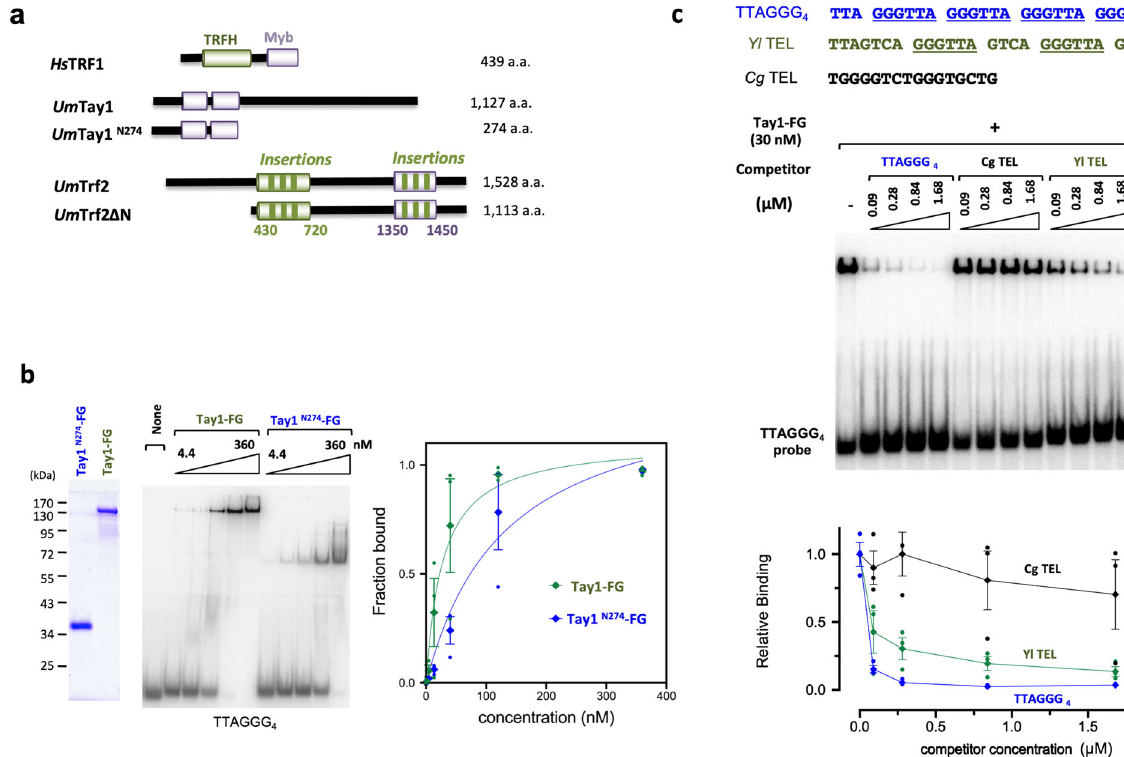
Fig. 1 The DNA-binding activity of Ustilago maydis Tay1. a Schematic illustrations of the domain structures of the U. maydis Tay1 and Trf2 proteins analyzed in this study, as well as that of human TRF1, a prototypical member of the TRF/TBF1 protein family. The TRFH and Myb domains are shown in green and purple, respectively. All the U. maydis recombinant proteins examined in this work also contain a C-terminal FLAG tag (as indicated by the designations Tay1-FG and Tay1 N274 -FG), which is not illustrated. b EMSA analysis of the DNA-binding activities of Tay1-FG and Tay1 N274 -FG (TayF1 and Tay1 N274 carrying a C-terminal FLAG tag). The assays were performed using a series of progressive, 3-fold increases in protein concentrations ranging from 4.4 to 360 nM. A representative set of assays is shown on the left and the quantitation (average ± SEM, n = 3 independent experiments) shown on the right. Previous investigations of Sp Teb1 revealed K d s that range from 20 nM to >1 µ M, possibly owing to the different DNA substrates used in these studies 12,50 . Our estimated K d s for Tay1 and Tay1 N274 (27 and 130 nM, respectively) are broadly in line with these earlier analyses. c The DNA-binding speci fi city of Tay1-FG was examined using three different double-stranded competitor oligonucleotides. The sequences of the competitors are shown on top with the canonical GGGTTA repeat unit underlined — only the G-strand sequences are displayed. Cg TEL and Yl TEL are based on the telomere repeat of Candida glabrata and Yarrowia lipolytica , respectively. A representative series of assays is shown and the quanti fi ed results (average ± SEM, n = 3 independent experiments) plotted on the